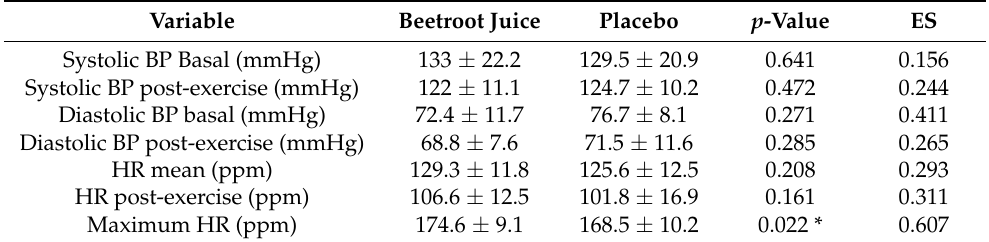
Table 1. Systolic and diastolic blood pressure basal and post-exercise, and heart rate during resis- tance